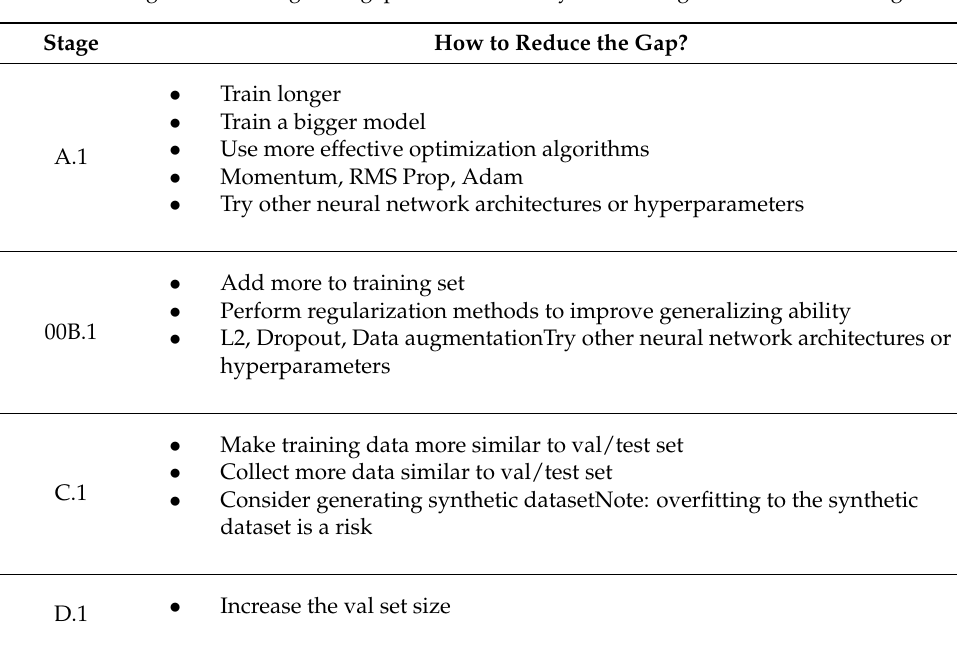
Table A4. Strategies in reducing error gap in the error analysis. The stages were defined in Figure